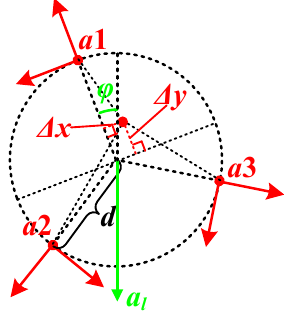
Figure 10. Description of the eccentric error.